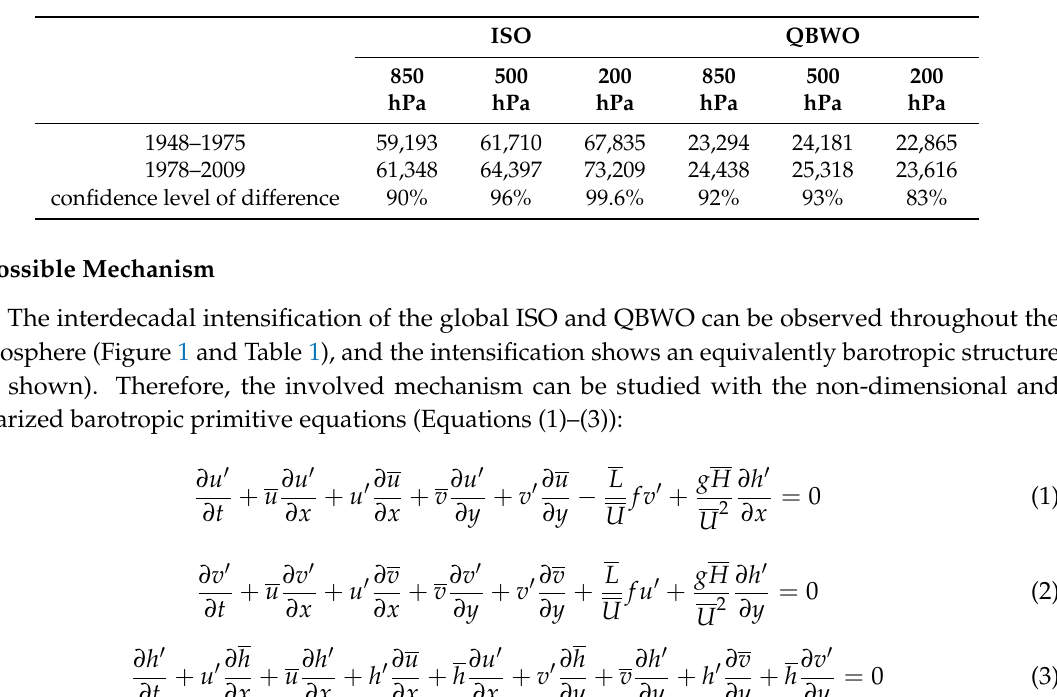
Table 1. The averaged spectrum values and their differences in the ISO and QBWO bands for the two sub-periods before and after the mid-1970s.